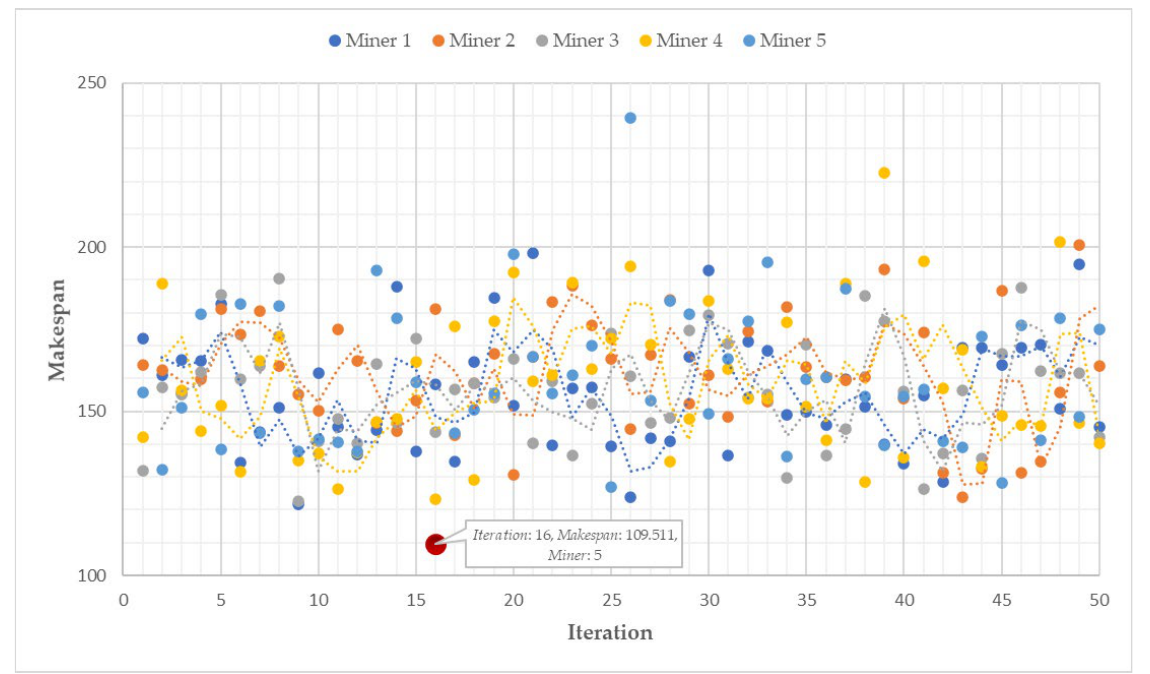
Figure 18. Collaboration of miners to determine the appropriate solution for the BoT scheduling problem in the entire search space (the number of tasks was 5000, and the number of computational resources was 200).